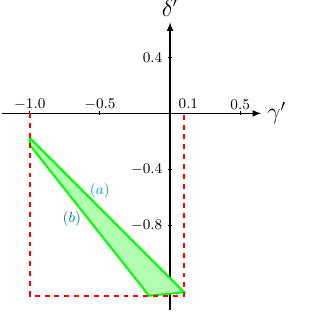
Fig. 7 Shaded area: overlap of the region − 1 < γ (cid:7) < 1, − 1 . 3 < δ (cid:7) < 1 . 3, giving R . 5 and 6 . 9. The two near straight lines 1 between 5 correspond to the experimental lower and upper limits of R 1 = 5 . 5 ( a ) and R 1 = 6 . 9 ( b )